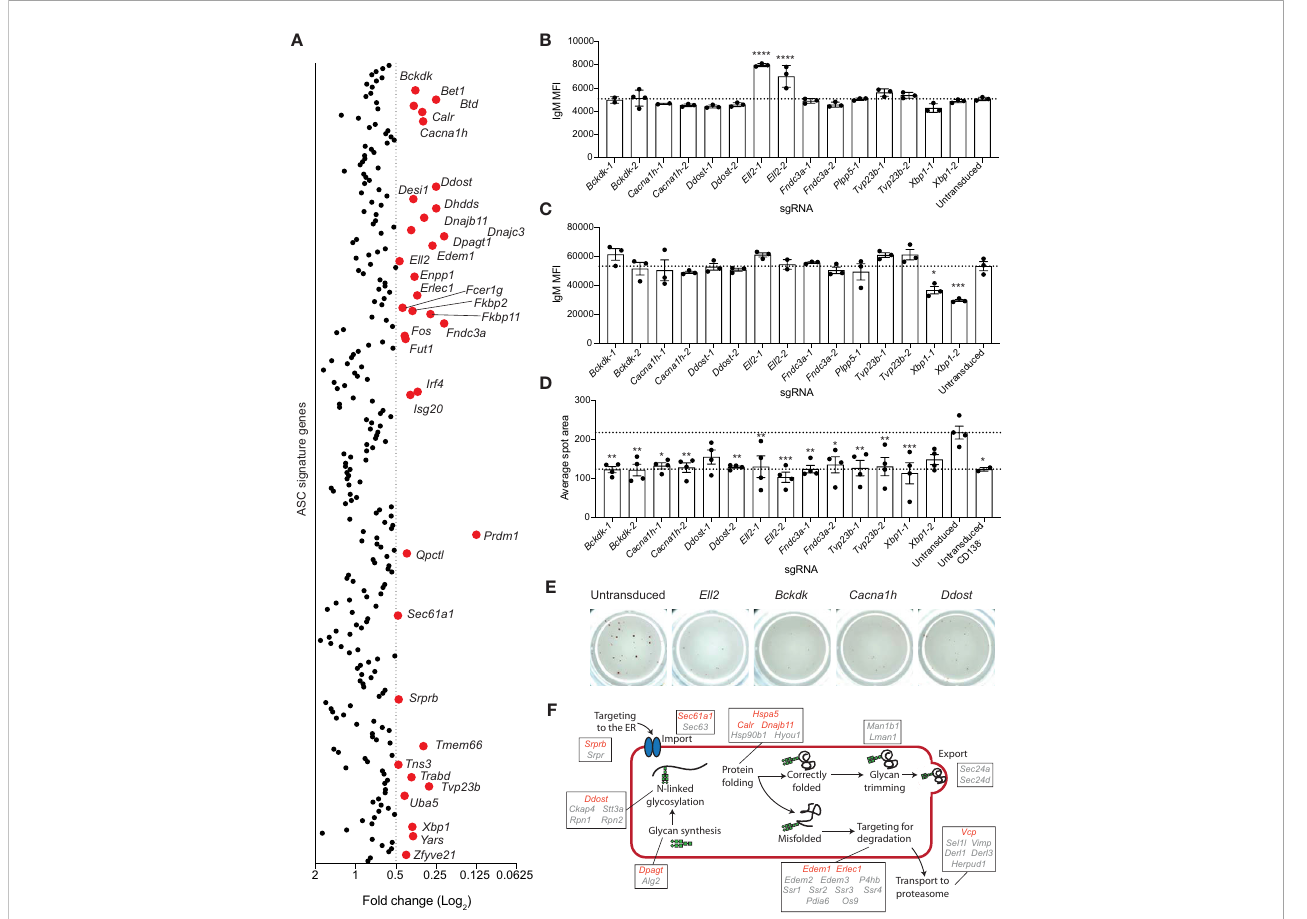
FIGURE 4 Genes essential for antibody secretion. (A) Experimental work fl ow is described in Figure 1A. The concentration of IgM in the culture supernatant was measure by ELISA and normalized to the live cell number. Data are presented as average fold change in IgM per cell for each targeted gene relative to the untransduced control. Genes with a fold change of ≤ 0.5 are labelled and highlighted in red. Data points represent the mean of 2 independent sgRNAs from 2 replicate experiments. (B, C) Naïve B cells from Cas9 transgenic mice were activated with LPS, transduced with sgRNAs targeting Xbp1 , Ell2 , Bckdk , Cacna1h , Ddost , Fndc3a , Tvp23b , or the Plpp5 control, and cultured for a further 3 days before analysis. Mean fl uorescence intensity (MFI) of IgM on the (B) plasma membrane or (C) total cellular IgM. (D, E) At 2 days post-transduction, transduced and untransduced cells were sorted and re- cultured overnight before transfer to ELISpot plates. (D) Average spot size formed and (E) representative wells are shown. Error bars indicate S.E.M. and dotted lines indicate the mean of the untransduced samples. Data in (B – E) are representative of 2-3 independent experiments. (F) Overview of the ER protein folding pathway (KEGG pathway: mmu04141) with genes within the ASC gene signature labelled. Red indicates secretion screen hits and grey indicates genes that did not reach the fold change cut-off. *p < 0.05, **p < 0.01, ***p < 0.001, ****p <